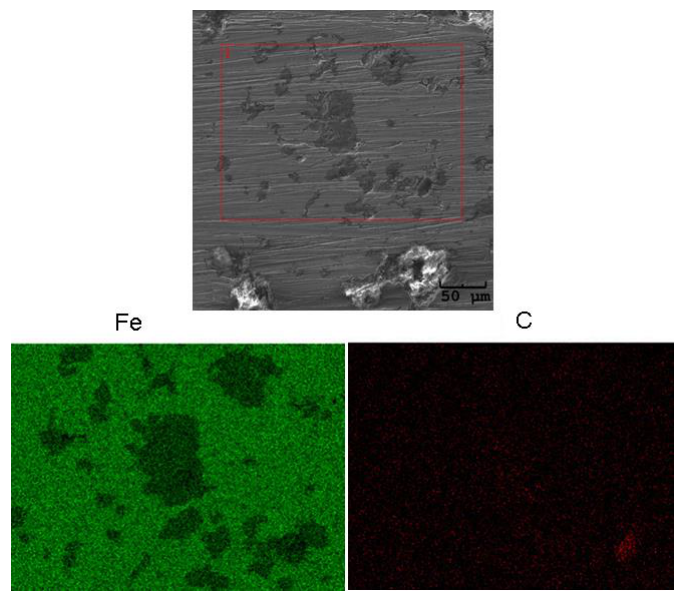
Figure 8. SEM image of the AISI 1010 carbon steel surface after the experiment in sulfolane at 95 ◦ C without etching and the potentiodynamic test: on-top general view of the material with a selected micro-region and with the corresponding energy dispersion spectroscopy (EDS) map of Fe and C element distribution. Materials 2019 , 12 , 3276